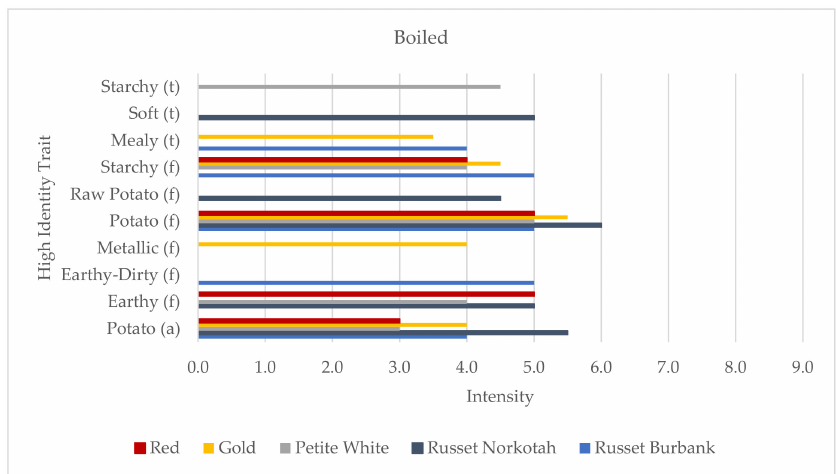
Figure 1. High identity traits (HITs) profiles of the boiled potato samples (aroma (a) the “smell” of the product; flavor (f), tastes, aromatics, and feeling factors while food is being eaten by the mouth; and texture (t)). Intensity was rated on a 0–15 scale with 0.5 increments. The mashed potato samples were also profiled using a total of ten HITs, with three traits for texture, six for flavor, and one for aroma (Figure 2). The mashed cooking method was the only one Gold, Russet Norkotah, and Russet Burbank samples all contained only four HITs. Starchy flavor and potato flavor were the only two traits out of the ten that were used to profile all five of the mashed samples, with the Red and Russet Burbank samples receiving the highest intensity scores for both. Unlike the boiled cooking method, potato aroma was only present in one sample, which was the Red variety. The Red sample was also di ff erentiated from the other samples by musty-earthy flavor. Other di ff erentiating traits included watery texture, which was only included in the Russet Burbank profile; gummy texture, which was unique to the Petite White profile; and cardboard flavor, which was only